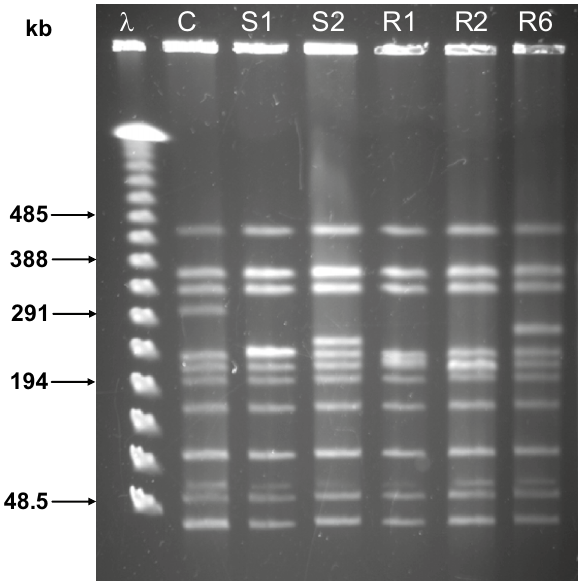
Figure 1. DNA of five recA isolates digested with NotI restriction enzyme and visualised by pulsed-field gel electrophoresis. S1 and S2 isolates have been obtained during normal lab propagation, and R1, R2 and R6 have been obtained after γ-radiation (see “Materials and methods”). The recA strain N1 with wt-like NotI pattern was used as control (C) and λ ladder as a size marker. Different NotI patterns were used as a prerequisite for the choice of isolates to be sequenced.